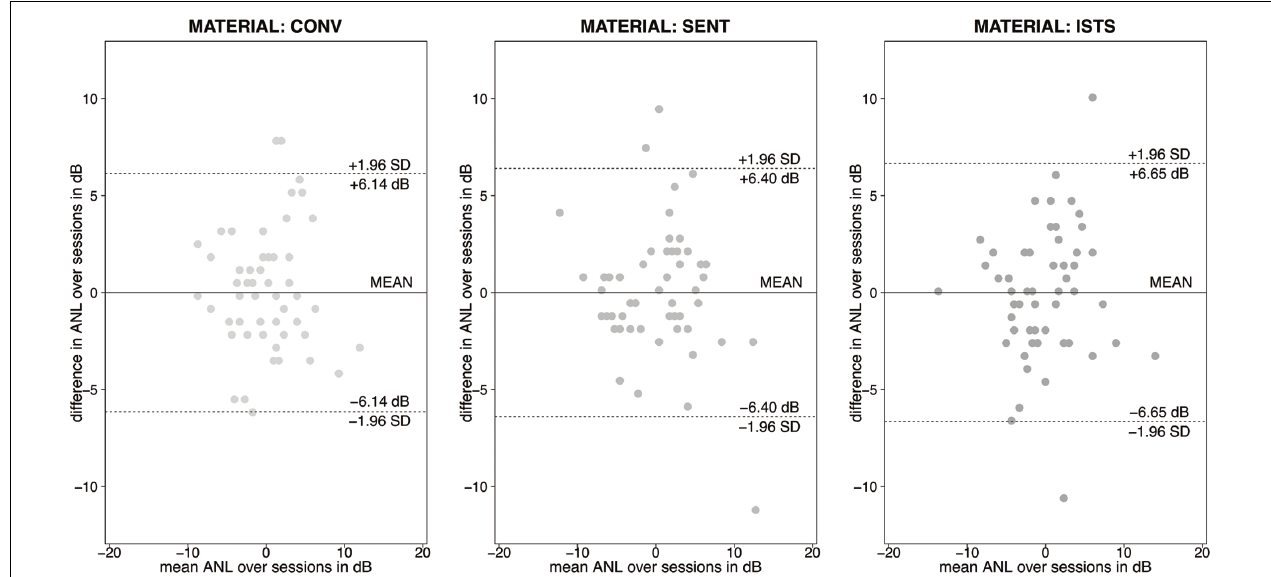
FIGURE 3 | Bland–Altman plots for repeated ANL tests using conversational (CONV), concatenated sentence (SENT) and ISTS material. Horizontal lines represent the mean of the differences over the two test sessions as well as the boundaries for the 95% confidence interval per material type.